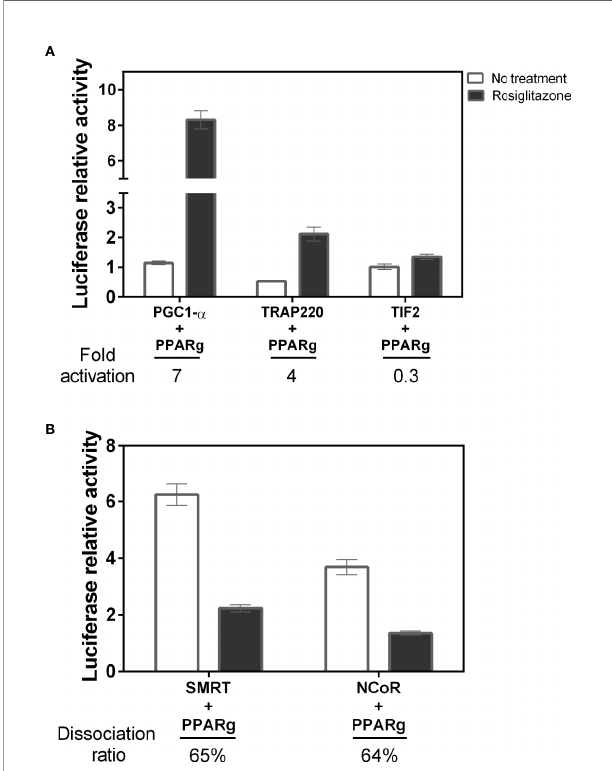
FIGURE 2 | Af fi nity of different coregulators with PPAR g . (A) The interaction with the PGC1- a coactivator was the highest among the coactivators studied, followed by TRAP220 that maintains the high activation due to the ligand. The TIF2 coactivator did not have a large increase in the presence of the ligand, suggesting low interaction after ligand binding. B) Among the corepressors the SMRT had a higher af fi nity than NCoR. Four assays in biological triplicate were performed to coactivators n=12, and three for corepressors CoRs n=9. (B) Among the corepressors the SMRT had higher af fi nity than NCoR Error bars, SEM.